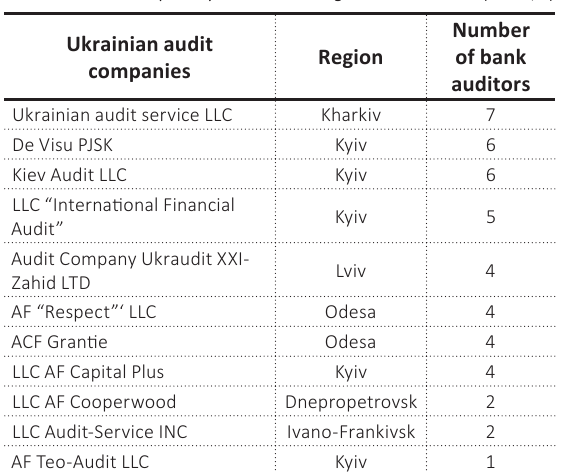
Table 4. Ukrainian companies in the bank audit market as public interest